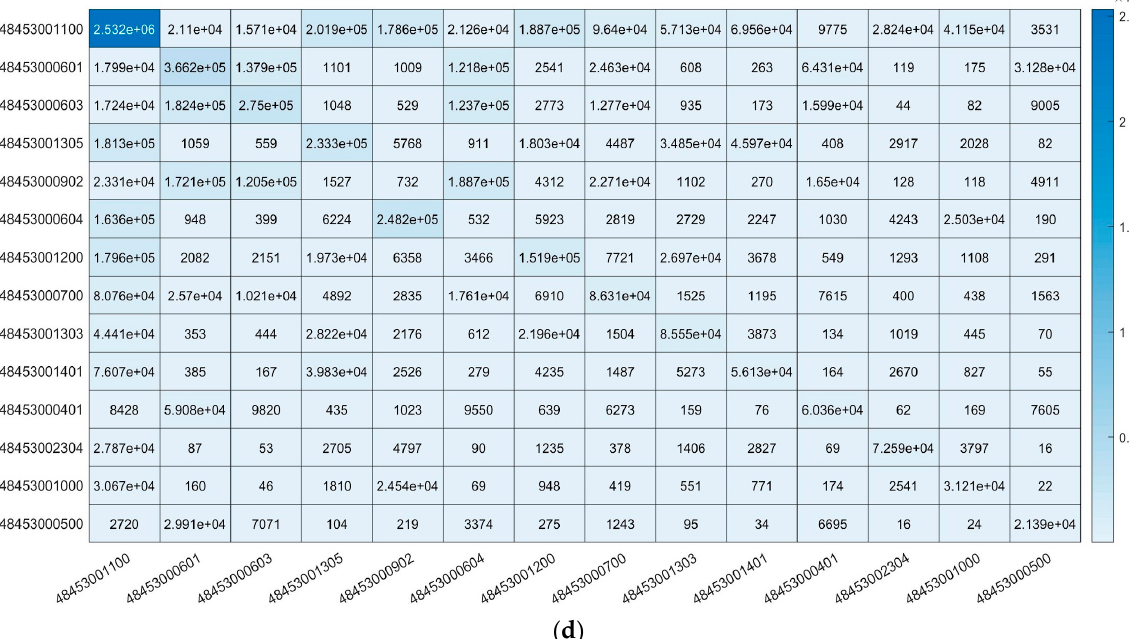
Figure 1. Most of the trips were concentrated in contiguous census tracts: ( a ) accumulated percentage of trips versus number of origins; ( b ) accumulated percentage of trips versus number of destinations; ( c ) 14 census tract that include approximately 90% of the total trips; and ( d ) heat map of the O–D matrix of the 14 census tracts.